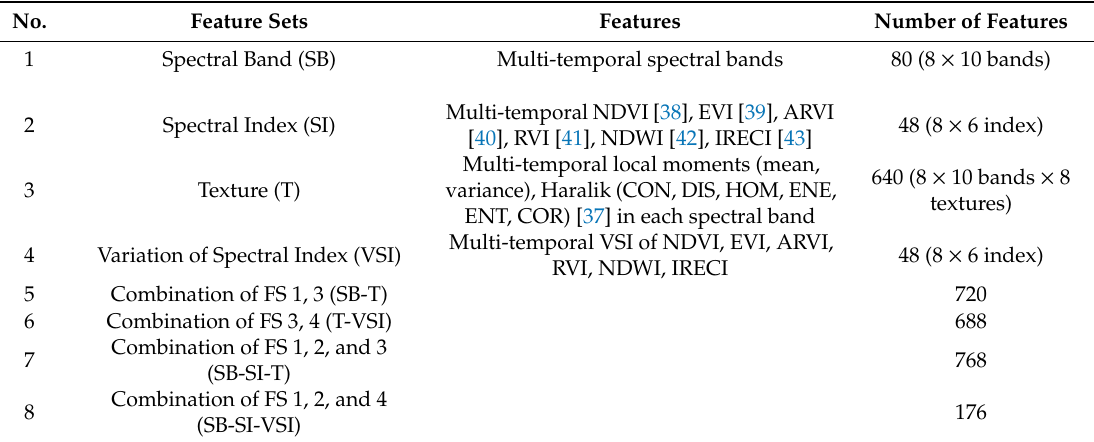
Table 2. Di ff erent feature sets and combinations of optical features for crop mapping.